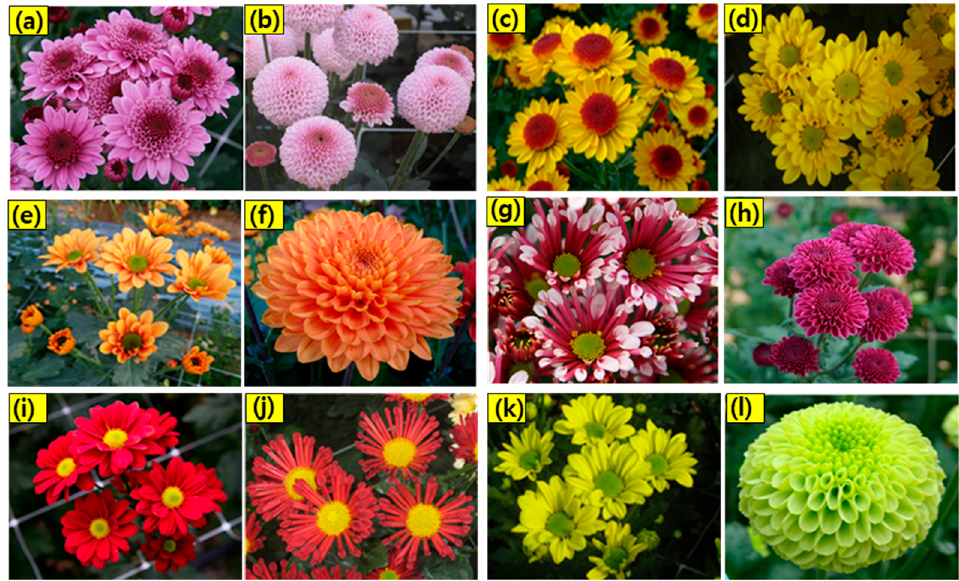
Figure 1. Representative images showing chrysanthemum cultivars with vibrant colors and diverse floral shapes developed by cross breeding at the National Institute of Horticultural and Herbal Sciences (NIHHS), RDA, Korea. ( a ) Glory Pink, ( b ) Pink Bubble, ( c ) Ilweol, ( d ) Yellow Marble, ( e ) Light Up, ( f ) Orange Pangpang, ( g ) Purple Cone, ( h ) Purple Pangpang ( i ) Red Marble, ( j ) 10B1-173, ( k ) Field Green, and ( l ) Green Pangpang.